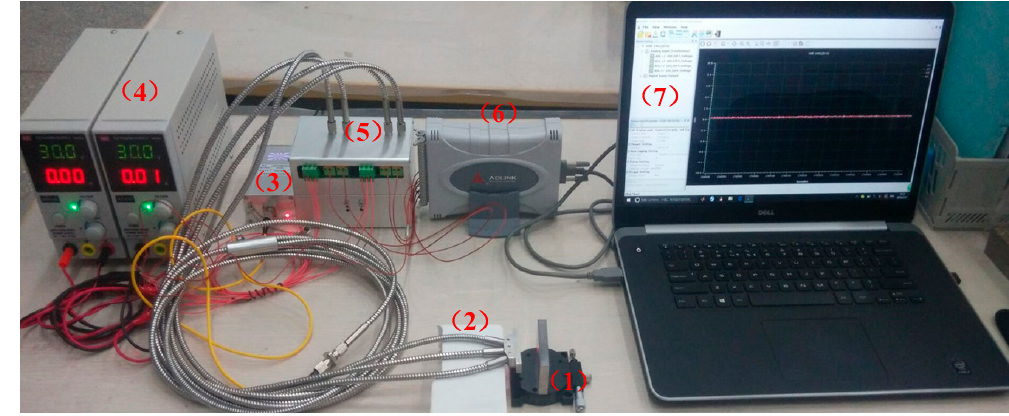
Figure 13. Static measurement experiment system of optical fiber angular displacement sensor.